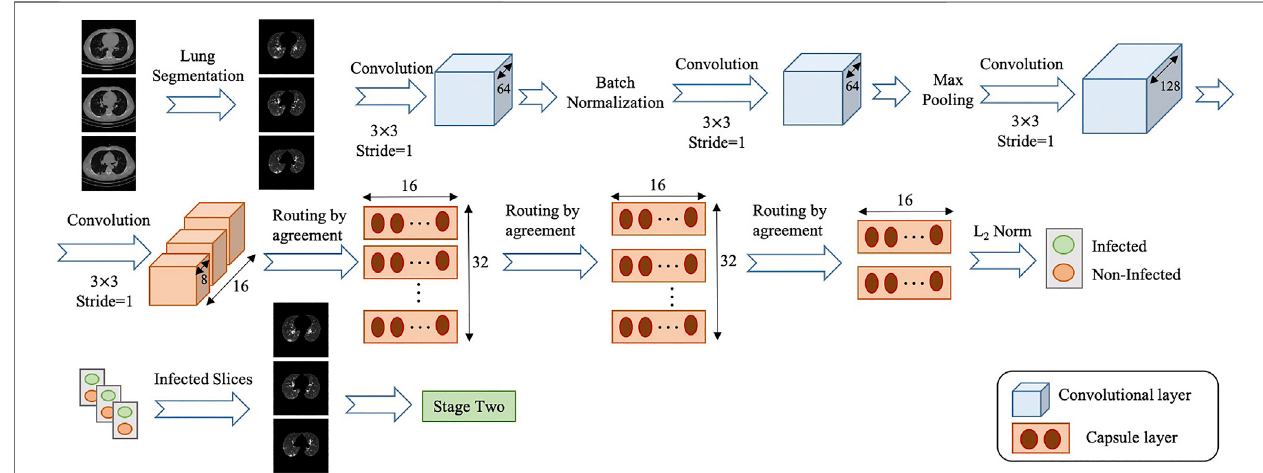
FIGURE 3 | Architecture of the COVID-FACT at stage